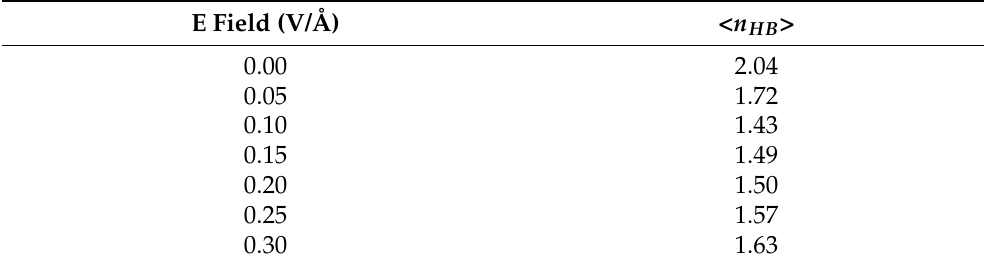
Table 1. Average number of H-bonds per molecule at different field strengths.